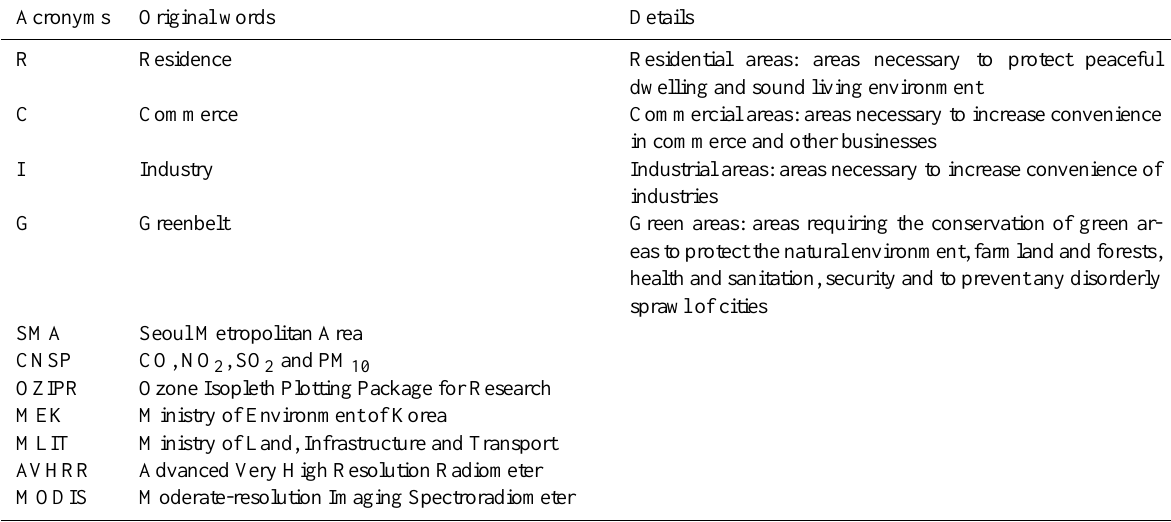
Table 1. List of acronyms used in this